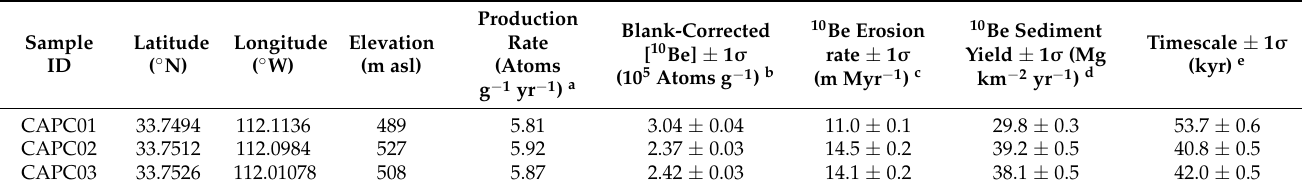
Table 2. Catchment averaged denudation rates (CADRs) in the controlled experiment based on cosmogenic 10 Be analyses. Sample ID number corresponds to the sampling locations that are presented in Figure 4. The CAP02 sample comes from the preserve, while CAP03 comes from the subdivision. The CAP03 sample integrates a larger drainage area that mixes preserve and development land